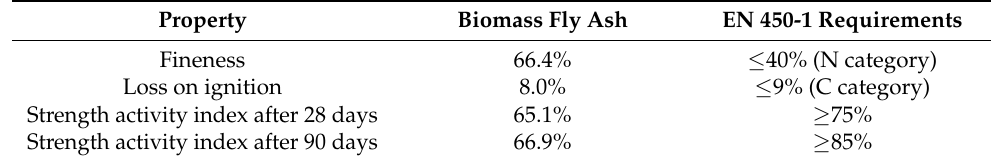
Table 2. Physical Properties of Biomass Fly ash.